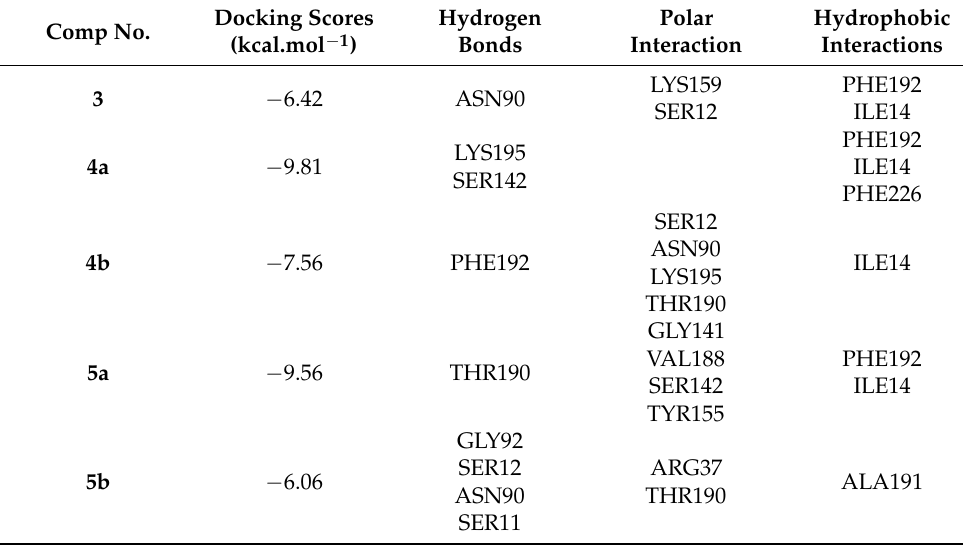
Table 2. Docking scores of synthesized compounds ( 3 , 4a , b , and 5a , b ) against 3HB5 (PDB: 3HB5).